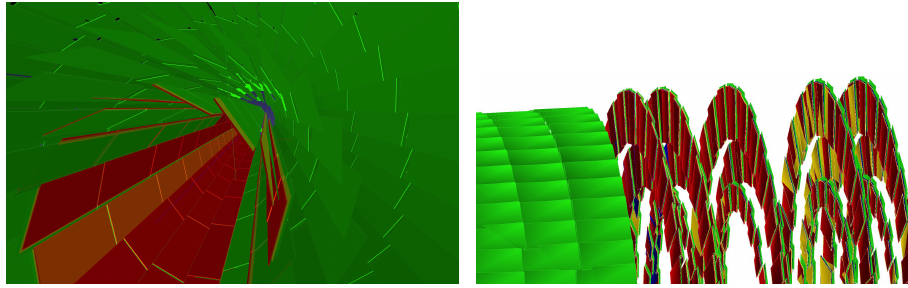
Figure 5. Exaggerated visualizations of the e ff ect of alignment constants for the Pixel detector on the left and the SCT endcaps on the right. The colors indicate di ff erent IOVs. The varying detector positions indicate that the sensor positions depend on the IOV. In the left image, the IOVs are from a single data taking run, and the bowing of the innermost sensor layer increases with the IOV as expected. The information is retrieved and applied